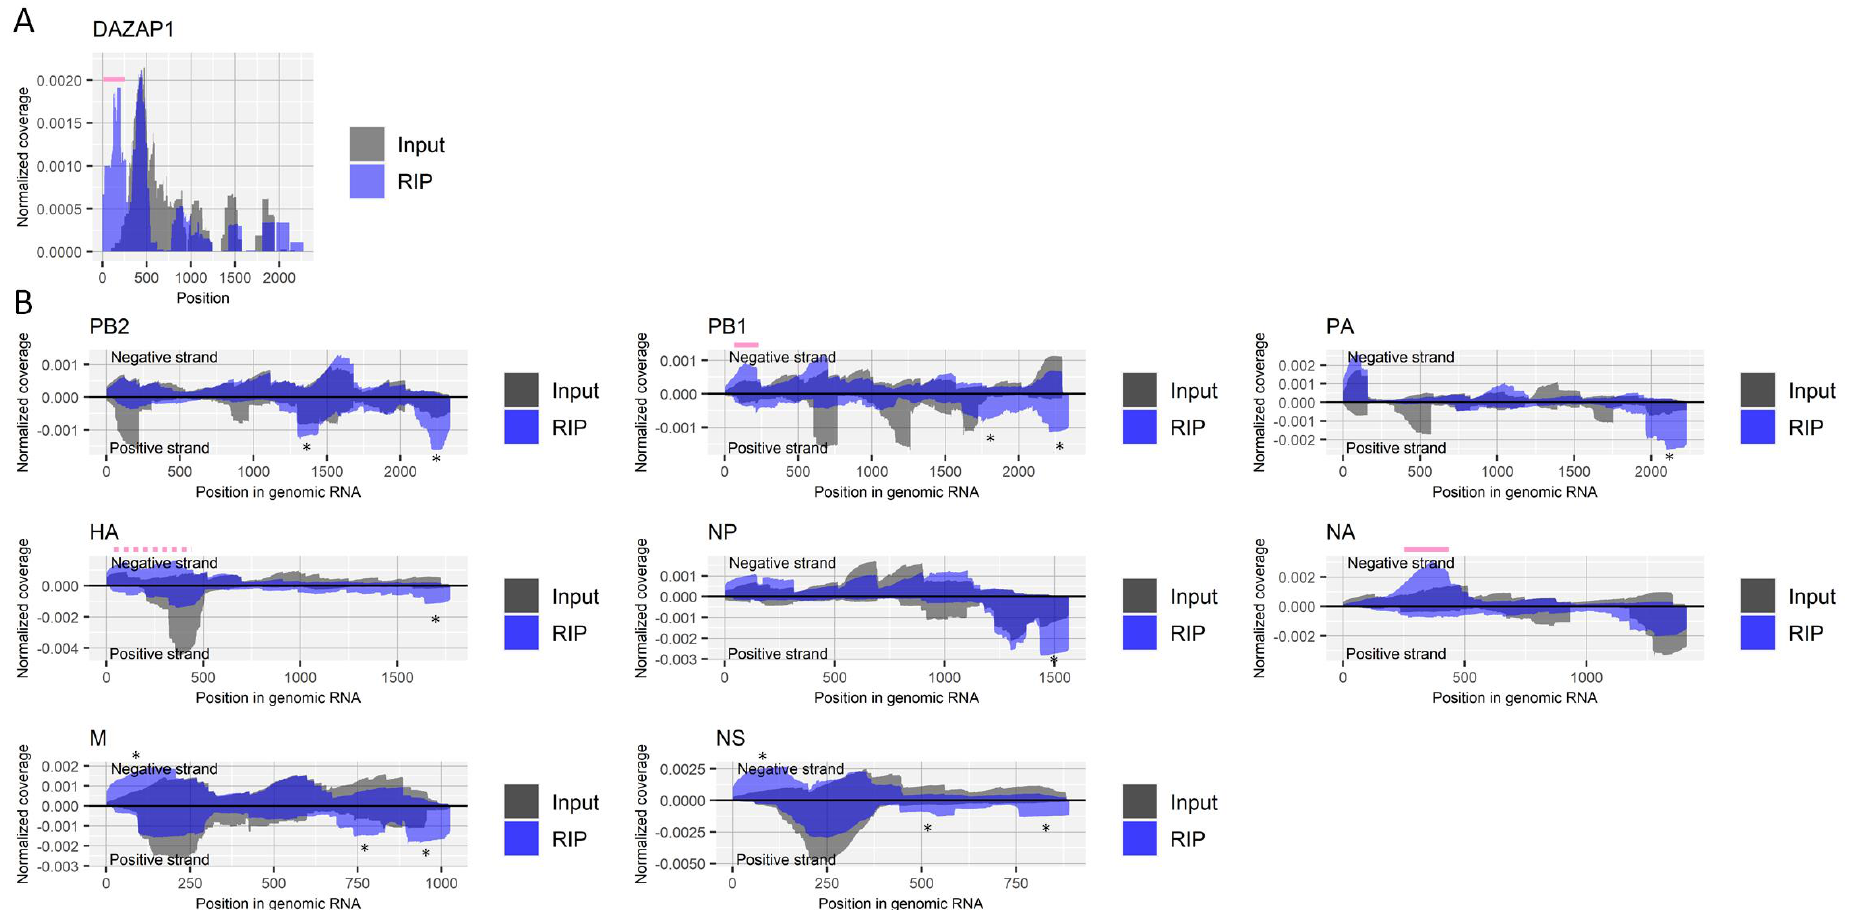
Figure 4. Detection of regions that include ac4C in RNA derived from influenza A virus. ( A ) Read coverage of deep-sequencing in the host’s DAZAP1 gene normalized by the number of read counts mapped to the transcript for RIP and input samples. A pink bar indicates a previously reported region with ac4C. ( B ) Read coverage of deep-sequencing in negative-strand RNA (positive values) and positive-strand RNA (negative values) of each viral segment normalized by the number of read counts mapped to each transcript for RIP and input samples. Solid and dashed pink bars indicate sharply and moderately enriched regions that possibly contain ac4C, respectively. The criteria to identify RIP-enriched regions were at least two-fold enrichment, ac4C antibody-specific enrichment, and enrichment in two biological duplicates. * non-specifically enriched region that was also observed in other experiments. Results of the biological replicate experiment are available in Supplementary Figure S4.